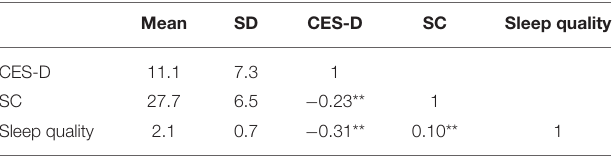
TABLE 2 | Correlation matrix ( n =